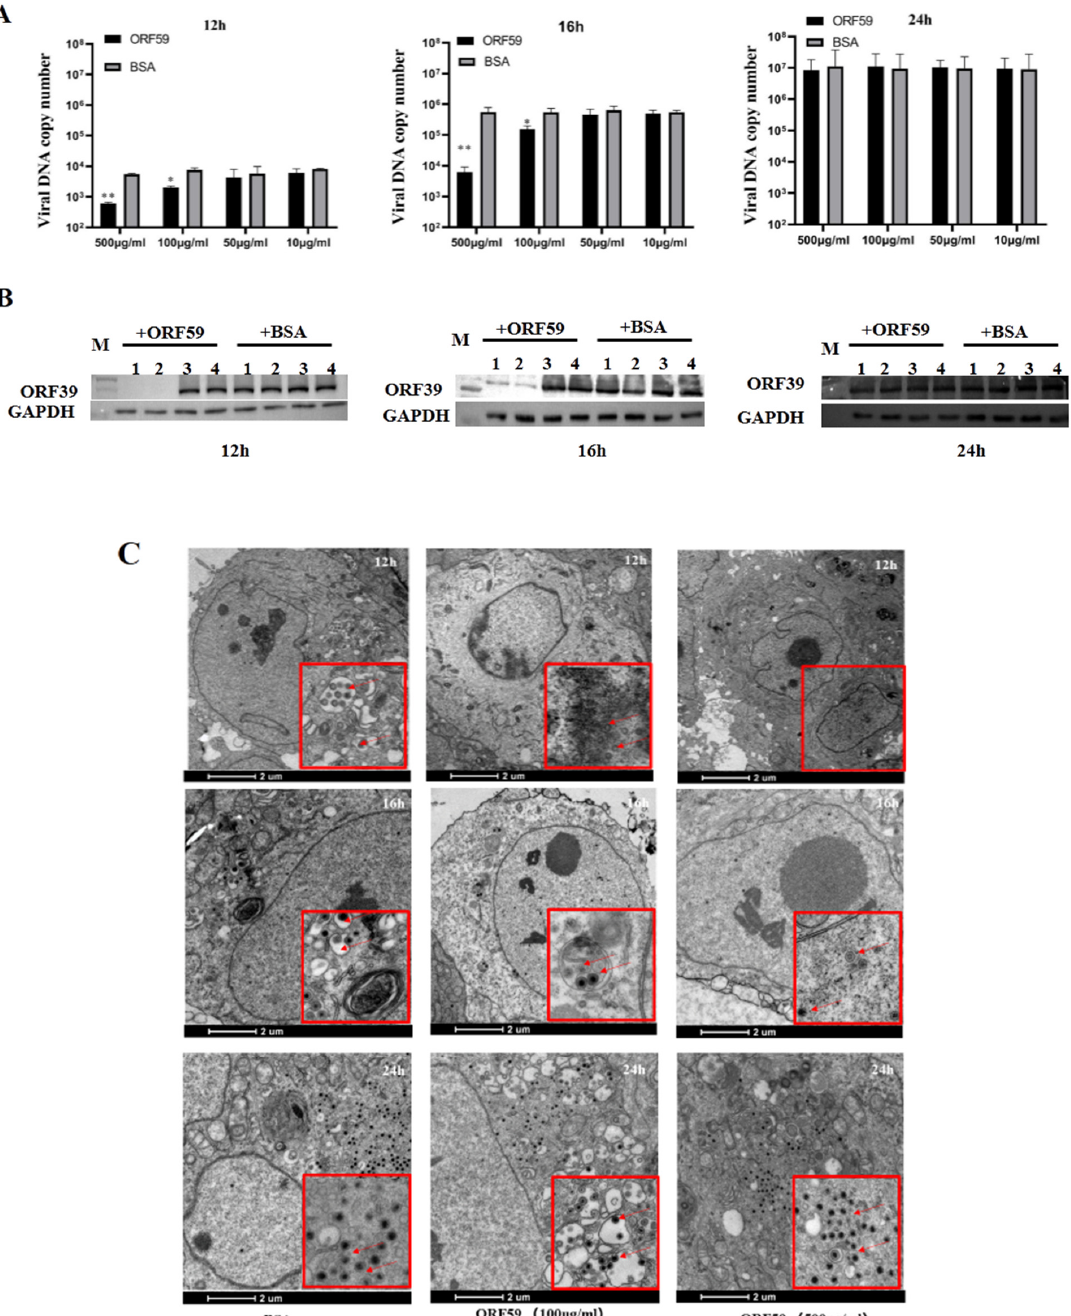
Figure 4. Recombinant ORF59 protein blocks CCV infection. ( A ) CCO cells were pre-incubated with different concentrations of ORF59 proteins at 28 ◦ C for 2 h, and then infected with 1000 TCID50/mL CCV. Cell samples were collected and the virus genome was measured using qPCR at 12, 16, and 24 hpi. BSA protein served as a negative control. Values represent mean ± SD (n > 3) for experiments performed in triplicate. * p < 0.05, ** p < 0.01. ( B ) The protein samples in A were analyzed by Western blotting at 12, 16, and 24 hpi. The viral major capsid protein ORF39 was probed using specific antibody, and GAPDH served as an internal reference protein. Lane: 1, CCO cells incubated with 500 µ g/mL concentrations of ORF59 proteins; Lane: 2, 100 µ g/mL; Lane: 3, 50 µ g/mL; Lane: 4, 10 µ g/mL. ( C ) The ultrastructural morphology of virions within infected cells examined using transmission electron microscopy. CCO cells were pre-incubated with different concentrations of ORF59 proteins (500 and 100 µ g/mL) and BSA (500 µ g/mL) served as a negative control. Arrows show viral particles. Bar = 2 µ m. CCV, channel catfish virus; CCO, channel catfish ovary; hpi, hours post-infection; qPCR, quantitative real-time PCR; BSA, bovine serum albumin; GAPDH, glyceraldehyde-3-phosphate